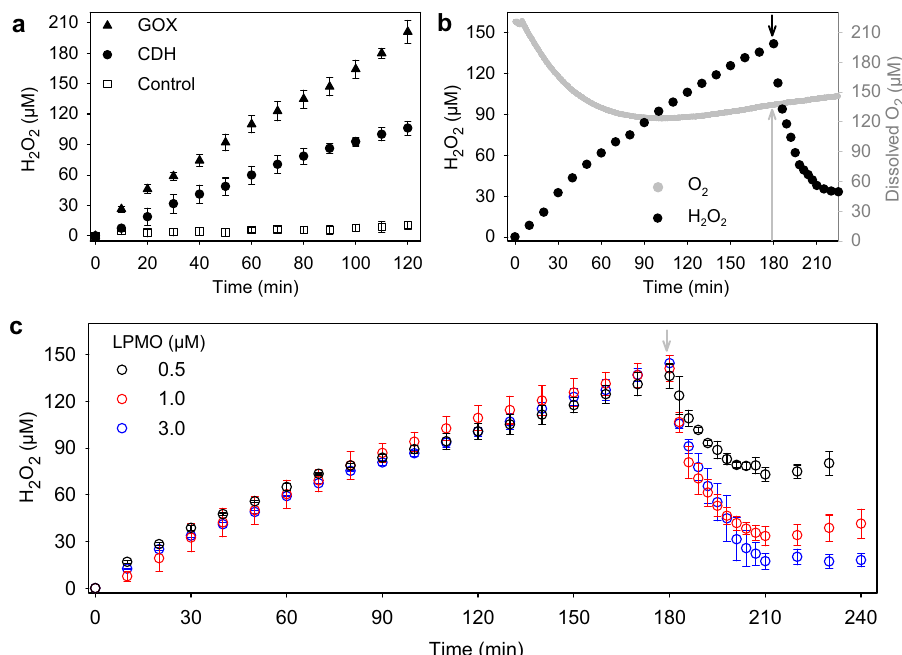
Fig. 4 | Detection of local H 2 O 2 formation and consumption in the vicinity of wood cell walls. a The graph shows time courses of H 2 O 2 formation by 2mgmL − 1 cellobiohydrolases and 1 µ M C. hotsonii CDH variant ( fi lled circles) or 2mgmL − 1 cellobiohydrolases and 1mgmL − 1 β -glucosidase in combination with 1 µ M GOX ( fi lledtriangles)duringhydrolysisofpoplarwoodcellwallsintheabsenceofLPMO. In the control experiment (empty squares), only 2mgmL − 1 cellobiohydrolase has been applied. b The change of O 2 (gray circles) and H 2 O 2 concentration (black circle) in the vicinity of wood cell walls before and after LPMO catalysis. The additions of 1 µ M LPMO9C and 1.0 µ M N. crassa CDHIIA are indicated by a black